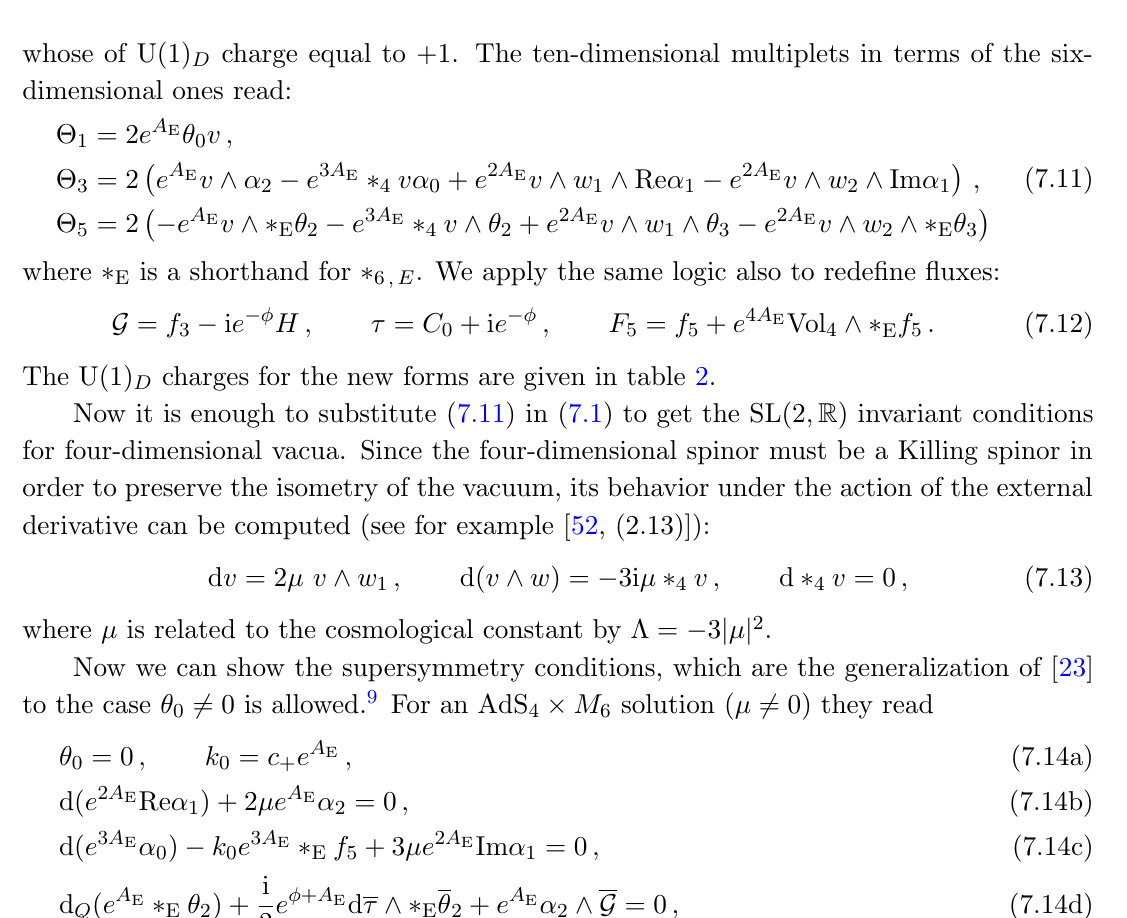
Table 2 . U(1) D charges of relevant (cid:12)elds on the internal